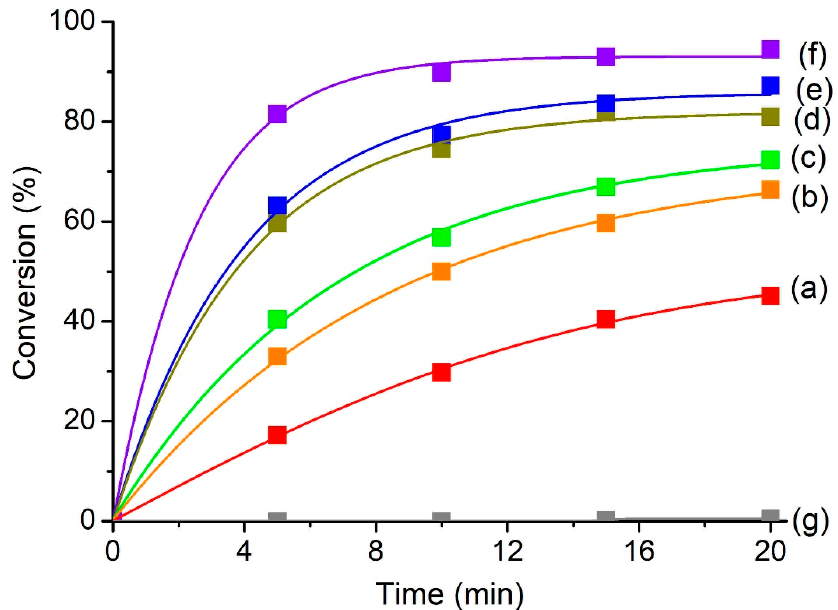
Figure 5. Acylation of 2-methylfuran catalyzed by ( a ) SAPO-5, ( b ) CuCl x /SAPO-5, ( c ) CoCl x /SAPO-5, ( d ) SnCl x /SAPO-5, ( e ) FeCl x /SAPO-5 and ( f ) ZnCl x /SAPO-5 at 110 °C. Reaction conditions: Catalyst = 0.20 g, 2-methylfuran = 4.7 mmol, acetic anhydride = 14.1 mmol, solvent-free. The reaction without adding any catalyst is shown in ( g ).